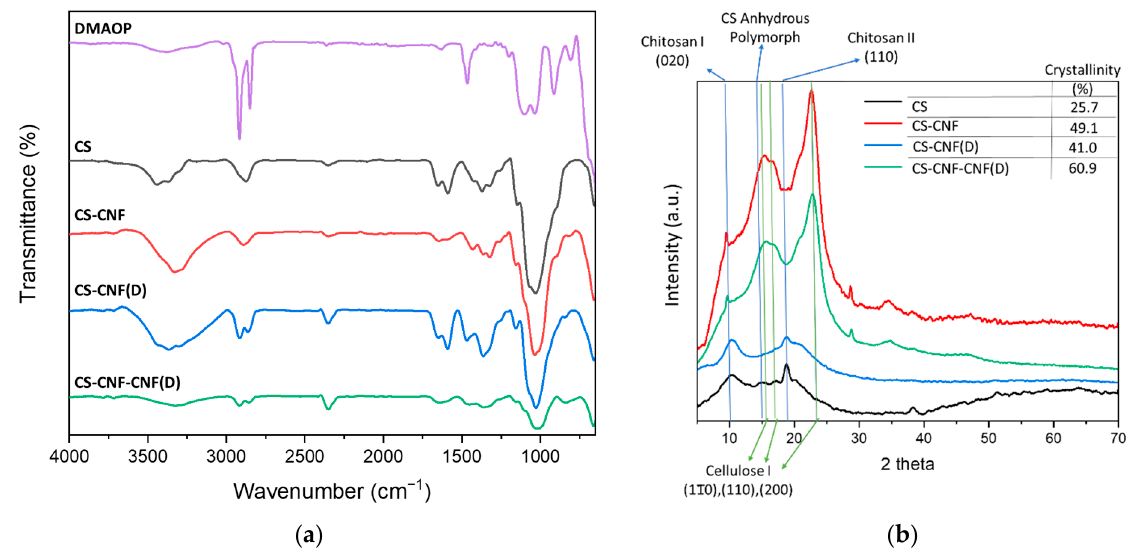
Figure 7. ( a ) ATR-FTIR spectral lines of CS membranes, including CNF(D) and corresponding reference membranes, and ( b ) X-ray diffractograms (XRD) of CS membranes containing CNF and CNF(D) fillers.